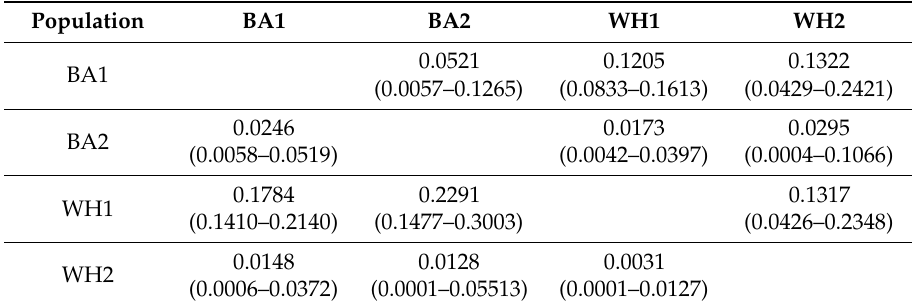
Table 6. Estimates of gene flow between Sitobion avenae biotypes collected on barley and wheat inferred from BayesAss